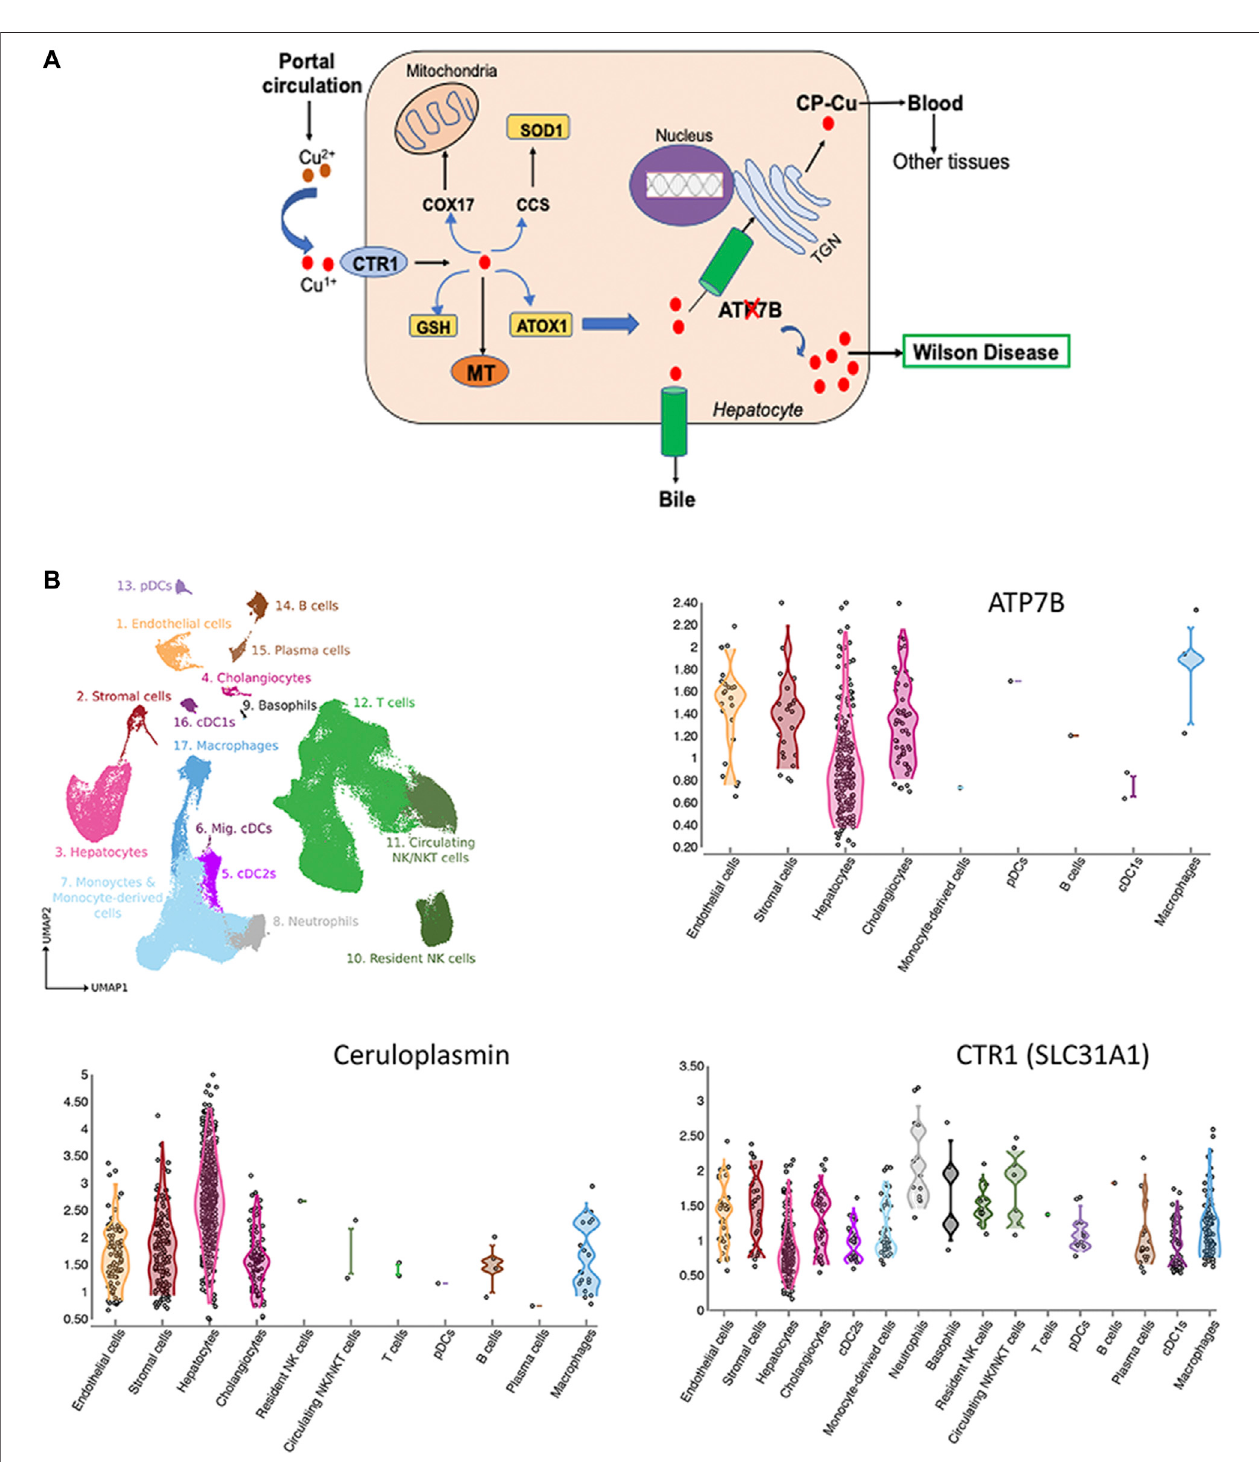
FIGURE1| Cu homeostasisinliver (A) and Cu-handlingproteins inliver cells (B).(A) Cuenters liver viaportal circulation and transportedinto livercells primarily by the high af fi nity uptake protein, CTR1. Cytosolic Cu chaperones shuttle Cu to speci fi c intracellular targets; CCS transports Cu to SOD1, ATOX1 -to the Cu-transporting ATPaseATP7B.ATP7BtransportsCuintothetrans-Golginetwork(TGN)forincorporationintoceruloplasmin(CP)andtotheapicalmembraneforexcretion.Inactivation of ATP7B causes Cu overload, which manifests clinically as WD (ATP7B-ATPase Cu(I) transporting beta polypeptide; CTR1-high af fi nity Cu uptake protein 1; MT- Metallothionein; GSH-Glutathione, ATOX1-antioxidant protein 1; SOD1-Superoxide dismutase; CCS-Cu Chaperone for SOD, COX17-Cytochrome C oxidase) (Lutsenko 2016; Cz ł onkowska et al., 2018). (B) Expression of ATP7B, CP and CTR in liver cells. The fi gure is generated using Liver Cell Atlas (https://www.livercellatlas. org/), which aggregates single cells sequencing data for human and animal livers.